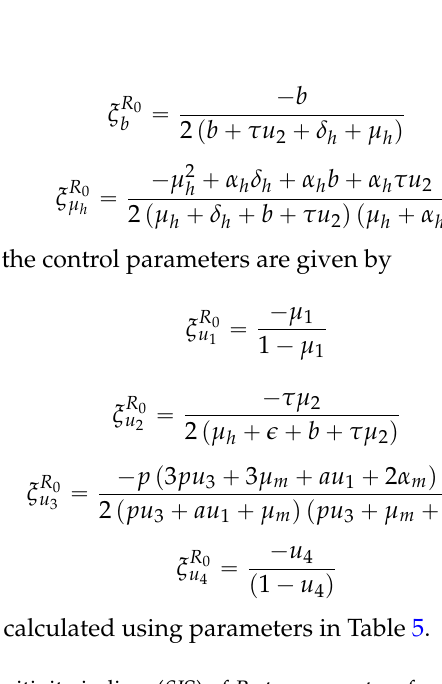
Table 4. Sensitivity indices ( SI S) of R 0 to parameters for the malaria model. Sensitivity Parameter